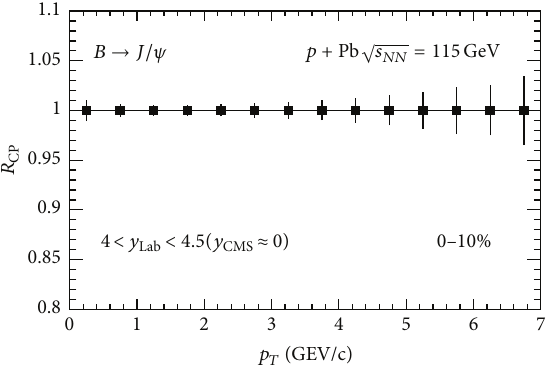
Figure 7: Expected statistical uncertainty of 𝑅 CP for 𝐵 → 𝐽/𝜓 in 𝑝 + Pb collisions at √𝑠 𝑁𝑁 = 115